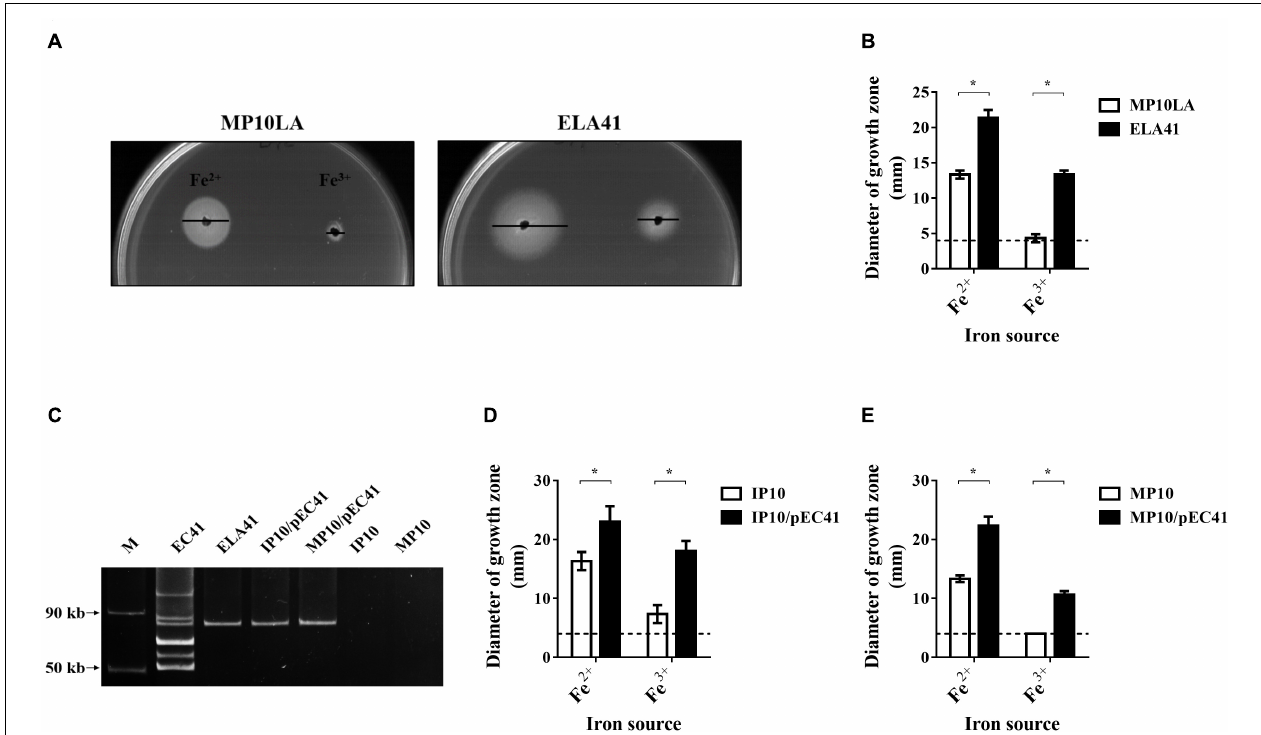
FIGURE 1 | The growth of the transconjugant ELA41 under iron-limited conditions and the plasmid the transconjugant obtained through conjugation. (A) Growth promotion assays of ELA41 and MP10LA with Fe 2 + (ferrous sulfate) and Fe 3 + (ferric chloride). Iron-limited medium (ILM) agar was seeded with ELA41 and MP10LA. Wells with a diameter of 4 mm were punched into agar plates and filled with 10 µ l of 10 mM ferrous sulfate and ferric chloride. The diameters of growth zones around the wells were determined after 24 h incubation at 37 ◦ C. Bars indicate the diameters of the growth zones. (B) Quantification of the diameters of the growth zones of ELA41 and MP10LA. Dashed lines indicate the diameter of the wells (4 mm) containing iron sources. The experiments were performed in triplicate and presented as the means ± SD. (C) The plasmid profiles of EC41, ELA41, IP10/pEC41, and MP10/pEC41. The plasmids were extracted using the method describe by Kado and Liu (1981). The plasmid extracts without any restriction enzyme digestion were subjected to agarose gel electrophoresis. Therefore, the plasmids in the gel were in a circular form. M: Fifty- and 90-kb plasmid markers. The markers were extracted from Salmonella choleraesuis OU7526 (Tzeng et al., 2012). (D,E) Quantitative analysis of the growth promotion assays of IP10 (D) and MP10 (E) strains with and without pEC41. The experiments were performed in triplicate and are presented as the means ± SD. * P < 0.05 (Wilcoxon rank-sum